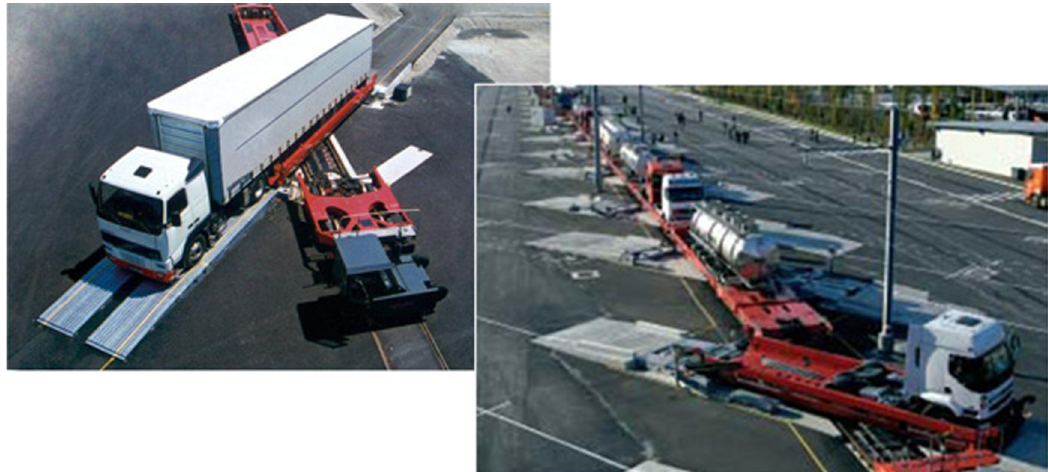
Figure 4: Horizontal transhipment technology ModaLohr, zdroj [ 12 ] .